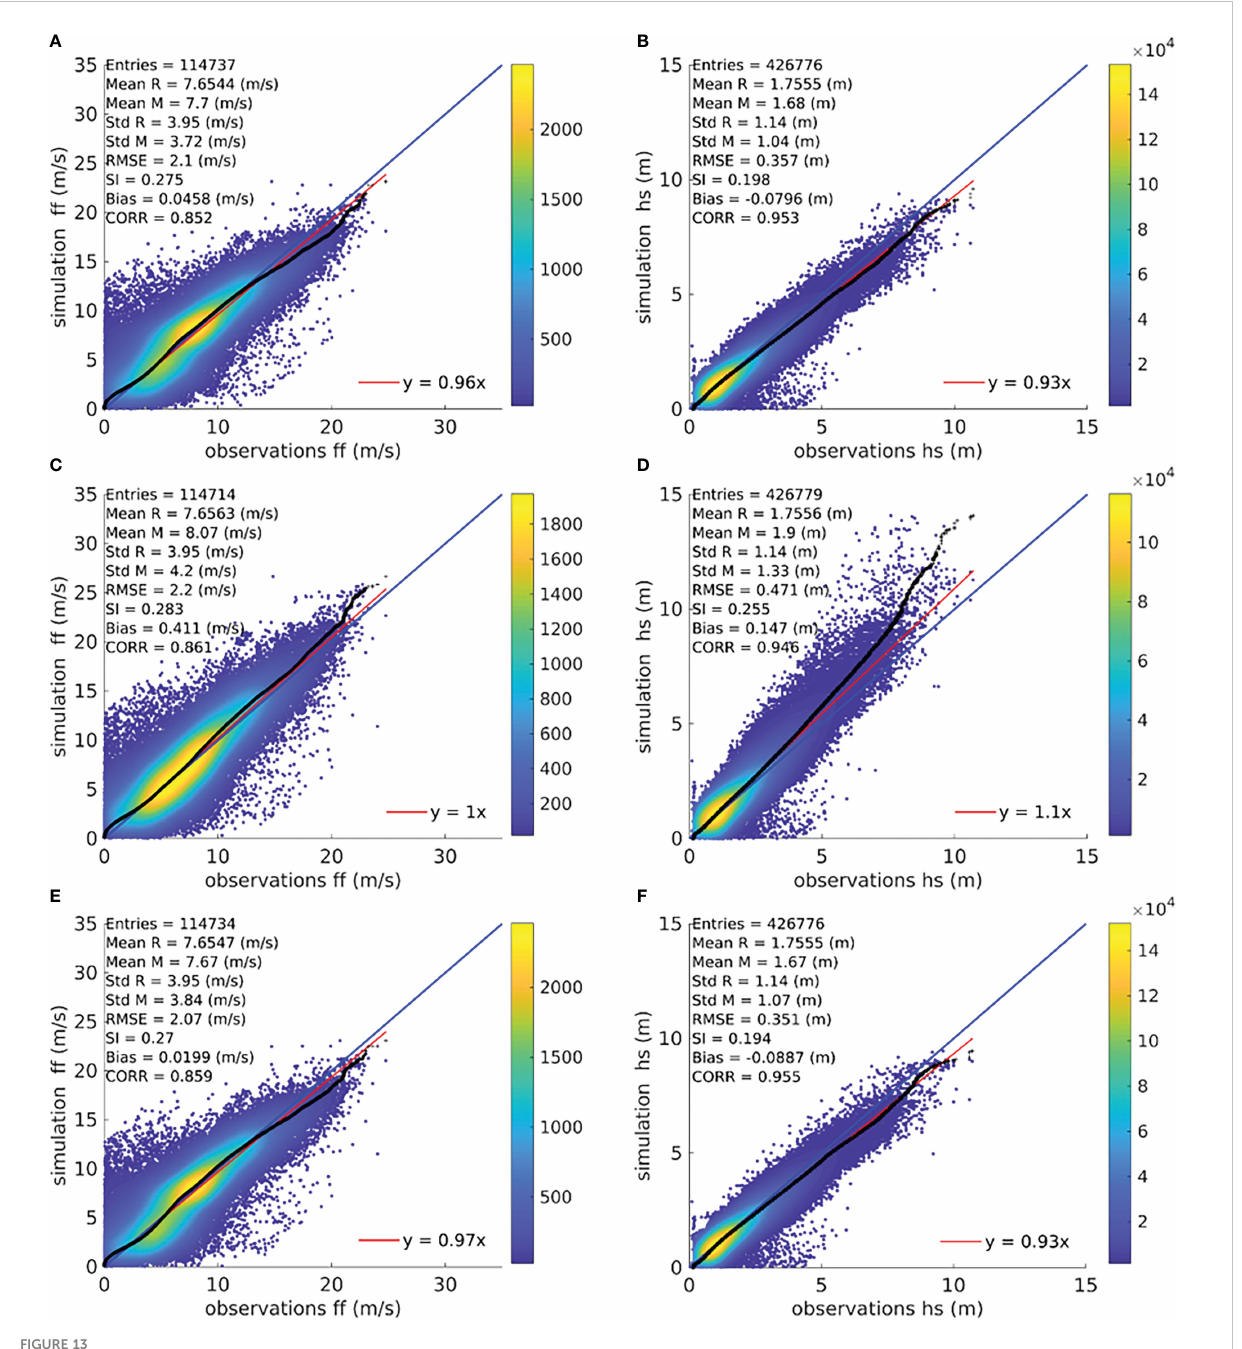
FIGURE 13 Q – Q scatter plots for the measured (GTS, J3) (reference, R) and modelled (M) wind speeds (left side) and signi fi cant wave height (right side) in the North Sea for AOW (A, B) , AO (C, D) , and AW (E, F) . The Q – Q plot is shown as black crosses, the 45° reference line is indicated by the blue line, and the least squares line with the best fi t is the red